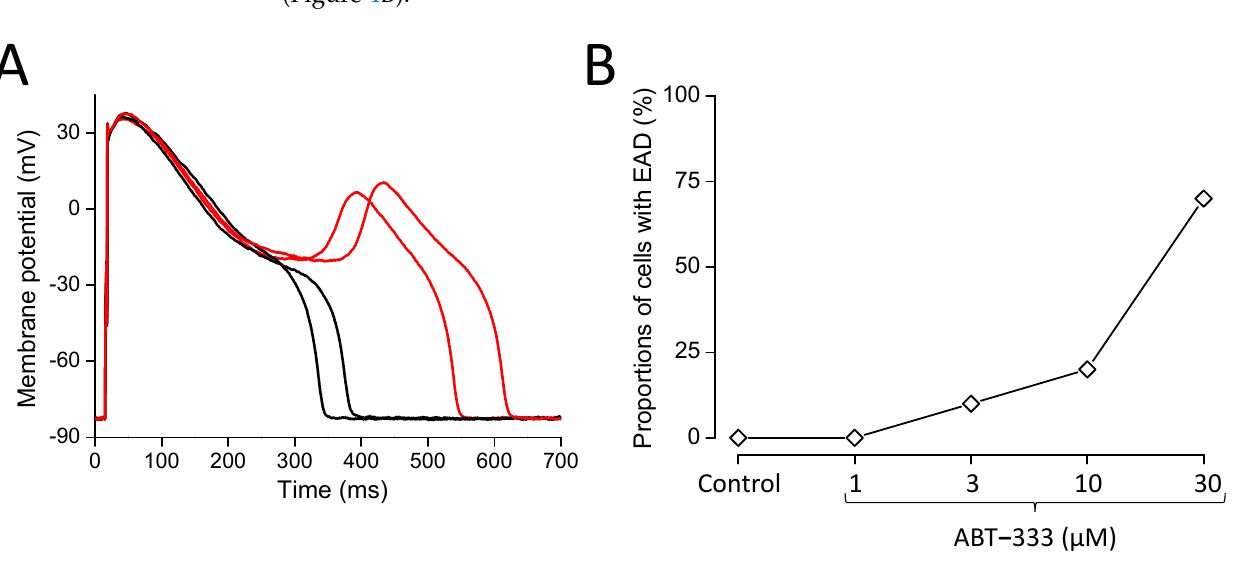
Figure 4. EAD formation in the presence of ABT-333. ( A ) Representative action potentials measured consecutively in the presence of 30 µ M ABT-333. Red traces show APs with EADs. ( B ) Diagram shows the percentages of cells developing EADs out of the 10 studied cells obtained from 7 animals.